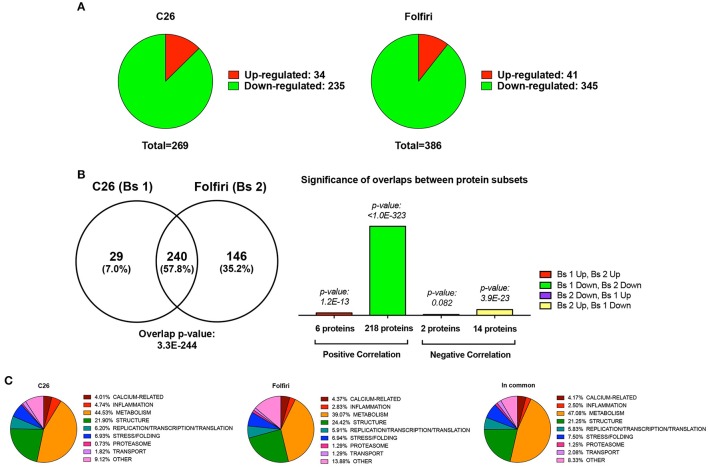
Cancer and chemotherapy promote the down-regulation of 235 and 345 muscle proteins, respectively. (A) Pie charts showing the number of proteins that are down-regulated (green) or up-regulated (red) following tumor growth (C26, left) or chemotherapy (Folfiri, right). (B) Comparative analysis between C26 and Folfiri biosets (Bs 1 and Bs 2, respectively). The Venn diagram (left) shows the number of proteins that are modulated in common or in the presence of either C26 or Folfiri. The overlap p-value, indicating the statistically significant overlap between the two datasets, is also reported. Analogously, the significance of the overlap between different protein subsets within the group of proteins modulated in both subsets is also presented (right). (C) The proteins detected in the C26 (left) and Folfiri (middle) datasets, or modulated in common (right) were classified based on their function and/or pathway and distributed as shown in the pie charts. The percentage is expressed over the total number in proteins in each dataset.